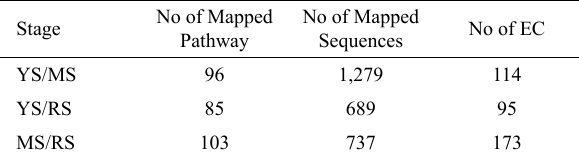
Table 4 − No of mapped pathways and sequences.